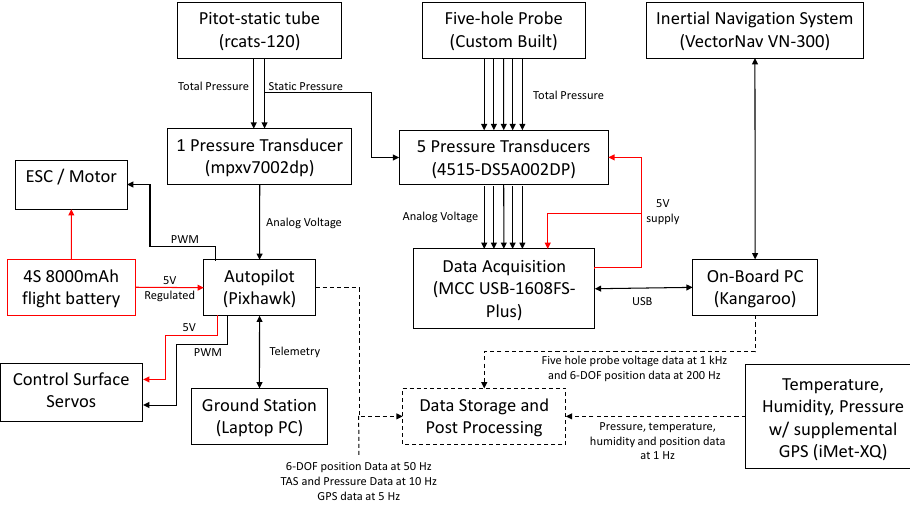
Figure 2. Diagram illustrating BLUECAT5 instrumentation connections. Red indicates supplied power; dashed lines indicate manual transfer of data post flight, rather than a hard-wired